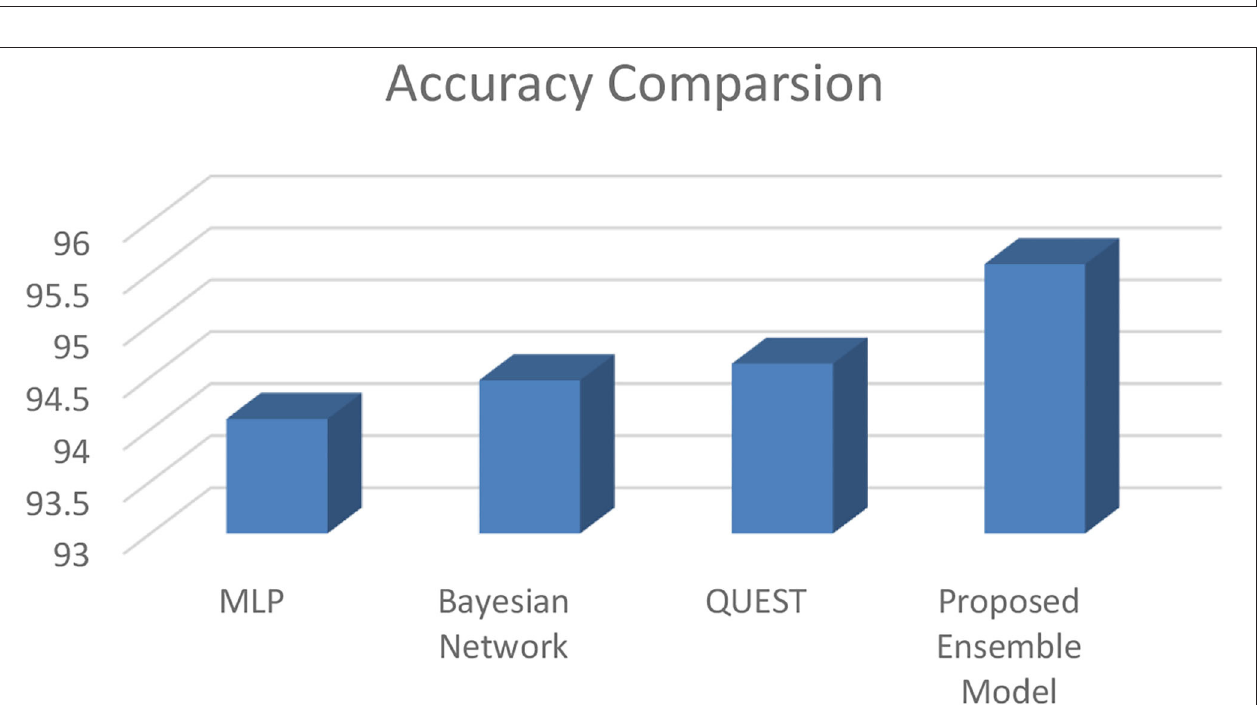
FIGURE 11 | Accuracy